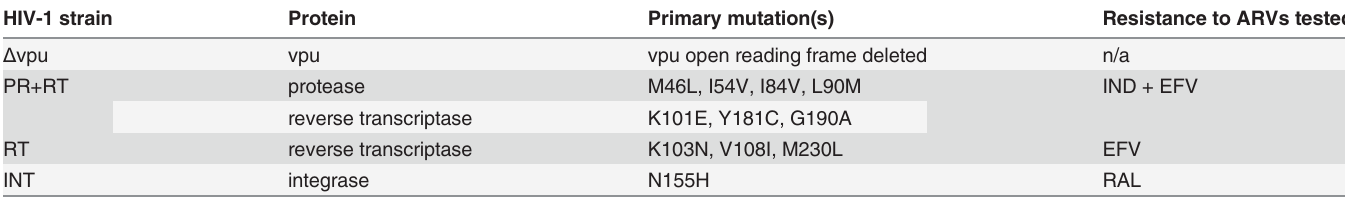
Table 2. Properties of HIV-1 strains lacking Vpu or encoding mutations that underlie resistance to ARVs. HIV-1